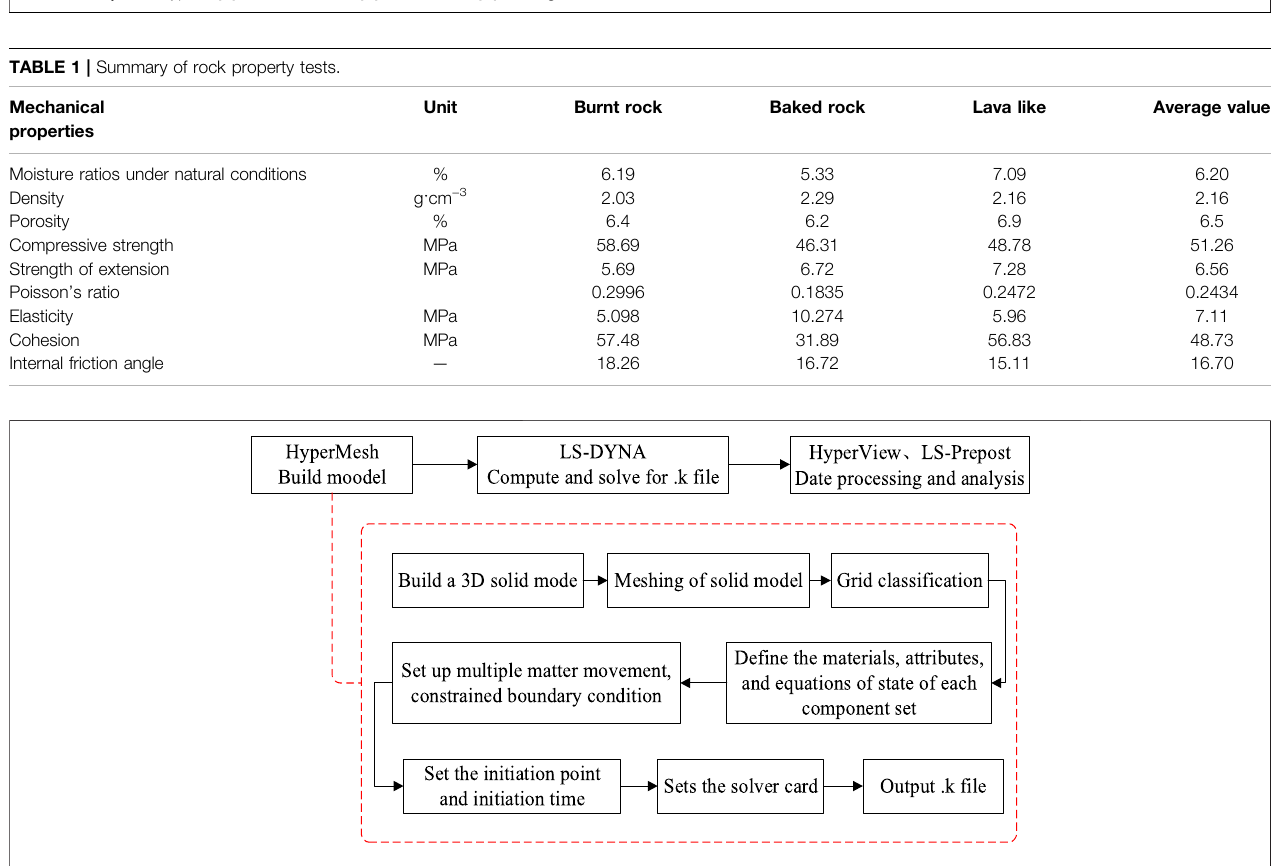
FIGURE 2 | Procedure of blasting